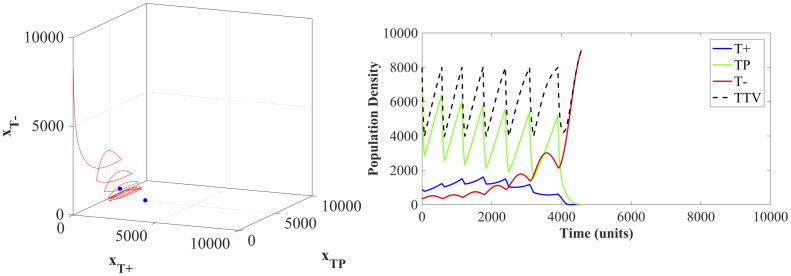
Adaptive therapy state dynamics.The state trajectory (left panel) and population densities (right panel) of an example patient under the adaptive therapy protocol. The two blue dots show the location of the two stable equilibria (two- and three- species).